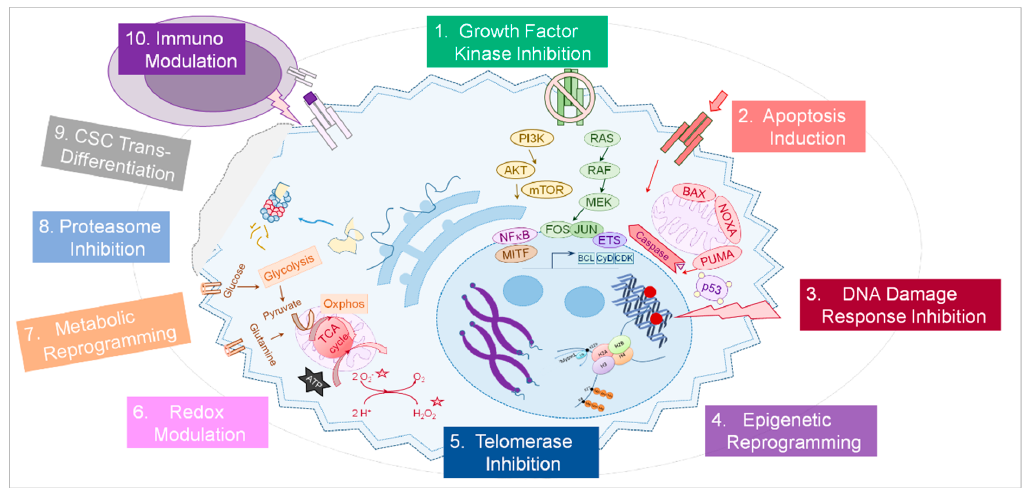
Figure 1. The principles of targeted cancer therapy. A number of physiological processes are potentially altered in a cancer cell (light blue) and can be targeted by small-molecules and other drugs (1–9, strongly simplified). In addition, immune cells (purple) can be targeted (10) as well as other cells of the tumor micro-environment (not shown). A more detailed description of each cellular process and the therapeutic ways to interfere with it is provided in the